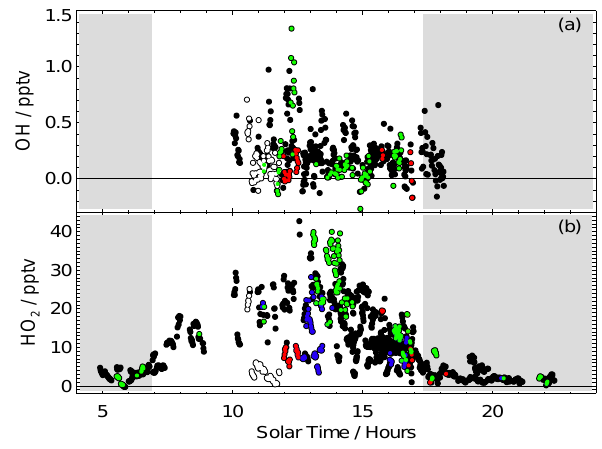
Fig. 10. Probability Density Function (PDF) of 60s averaged obser- vations (solid black lines): (a) OH, bin size of 0.02pptv (b) HO 2 , bin size of 0.5pptv. PDF of limits of detection (red dashed lines).